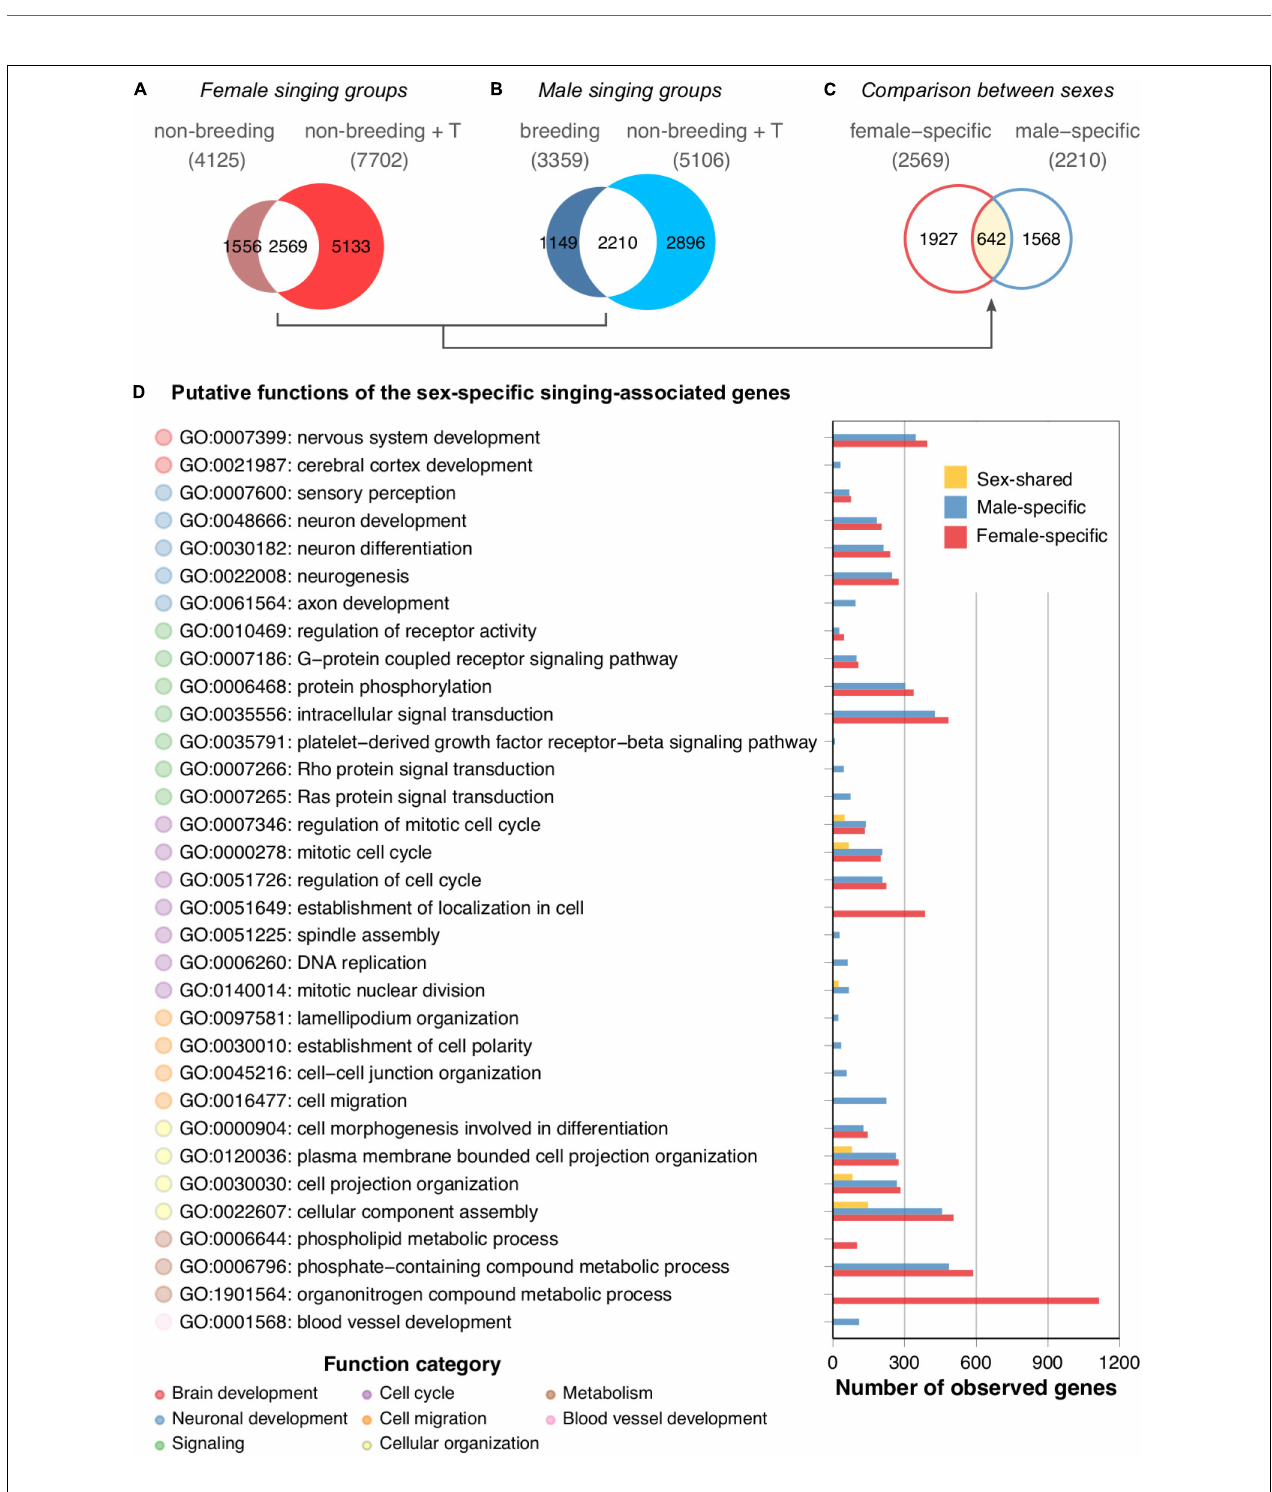
FIGURE 4 | HVC transcriptomes of naturally singing canaries are dissimilar from testosterone-stimulated singing canaries. Venn diagrams comparing (A) the two female singing groups, (B) the two male singing groups, and (C) the female- and male-specific expressed genes resulting from comparisons of panel (A) and panel (B) . Note that only approximately 20% of the genes were shared among the singing females and approximately 26% were shared among the singing males. The majority of these overlapping genes were not sex-shared; approximately 75% of female intersections were specific to female groups, whereas 71% of male intersections were specific to male groups. (D) GO term enrichment analysis of female-specific, male-specific, and sex-shared expressed genes derived from comparisons of panels (A) to panel (C) . Because many putative functions show similarities between male- and female-specific expressed genes, the results suggest functional intraspecies convergence based on sex-specific gene expression in the HVC. See Supplementary Table 7 for the full results of the GO term enrichment analysis.